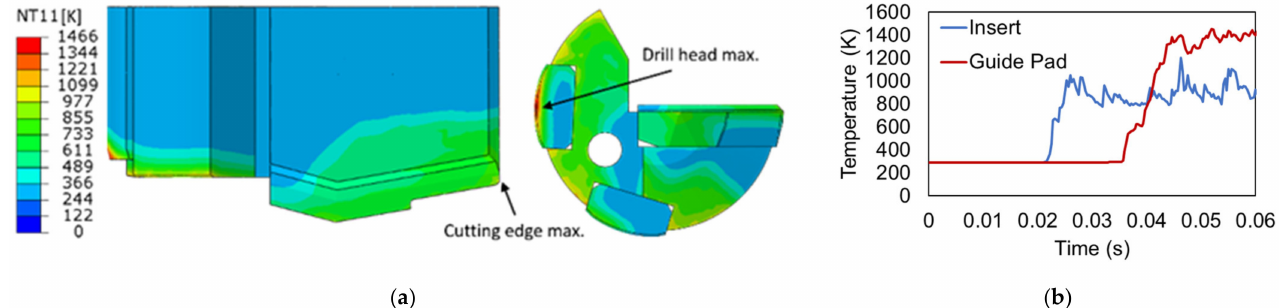
Figure 8. Temperature in the drill head under the following cutting conditions: a feed of 0.64 mm/rev and a cutting speed of 472.5 m/min ( a ). Development of the maximum temperature at the cutting edge and the drill head with a feed of 0.64 mm/rev and a cutting speed of 472.5 m/min in the simulation ( b